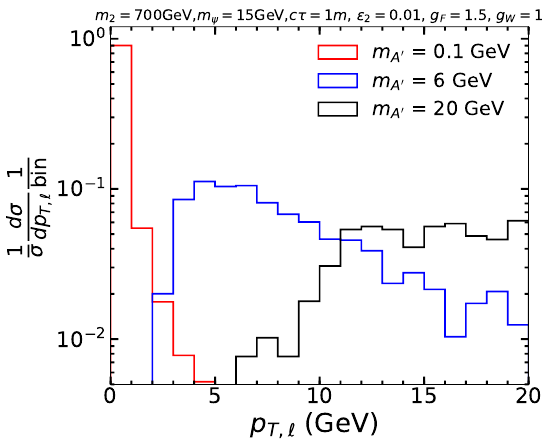
Figure 4 . The p T distribution of the leading lepton. We choose m 2 = 700 GeV, m = 15 GeV, c(cid:28) = 1 m, (cid:15) 2 = 0 : 01, g F = 1 : 5 and g W = 1 : 0. The red, blue and black lines indicate the dark photon mass of 0.1 GeV, 6 GeV and 20 GeV